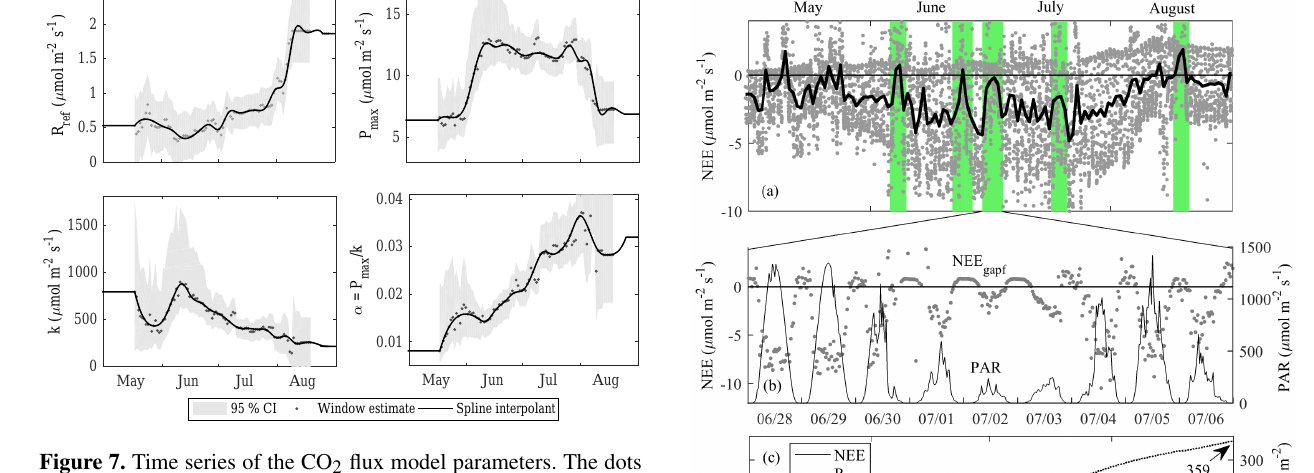
Figure 7. Time series of the CO 2 flux model parameters. The dots are the daily values evaluated in a moving time window, and the solid line is a spline interpolant, while the shaded area shows the 95% confidence interval, which is calculated at each time window step. The interpolated parameter lines stretch to the beginning of May and end of August, showing the constant values used at the edges of the study period.